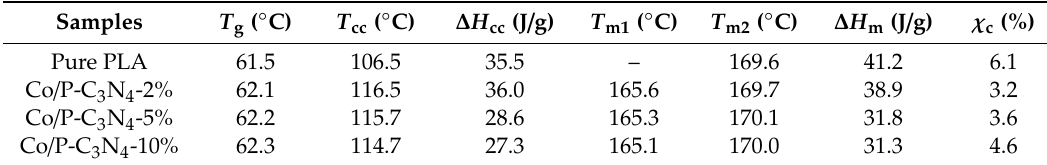
Table 3. TGA data of PLA composites.